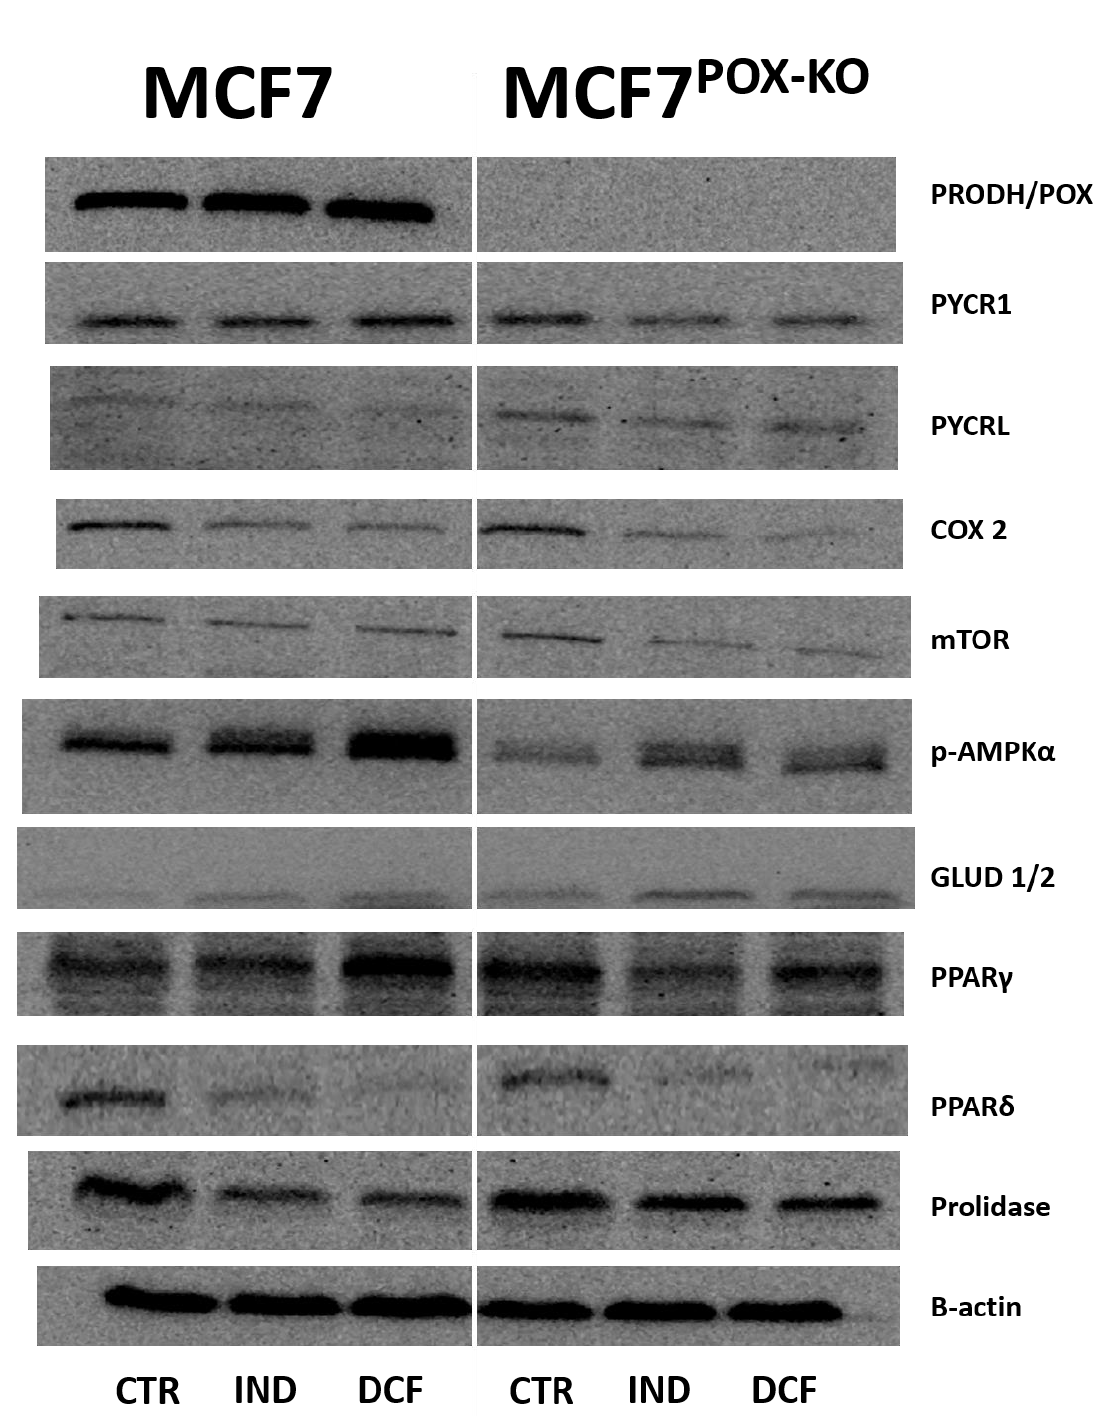
Figure 4. Western blot for proteins involved in PRODH/POX-dependent functions in MCF7 and MCF7 POX-KO cells treated for 24 h with 0.5 mM indomethacin (IND) and 0.375 mM diclofenac (DCF). For the experiment 40 µ g/lane of protein lysates was used. Protein expression was normalized versus β -actin expression.